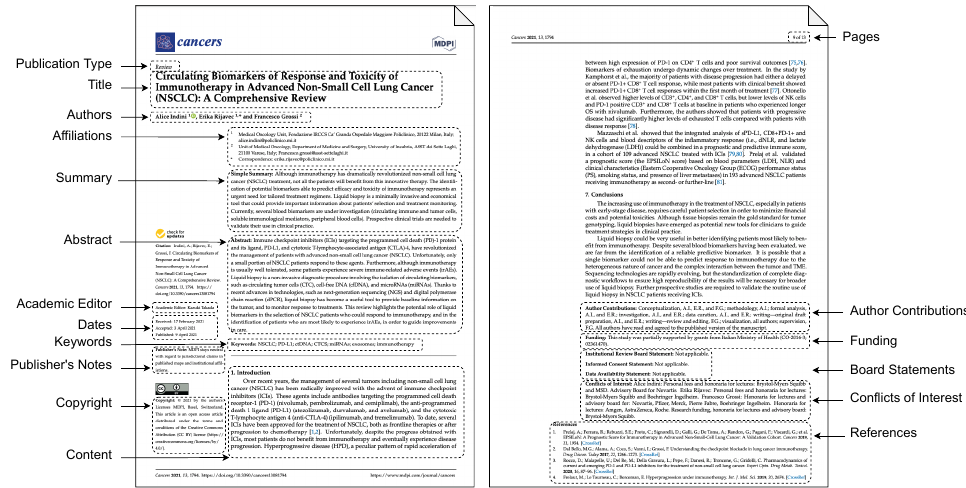
Figure 1. Example conference proceedings publication highlighting bibliographic metadata